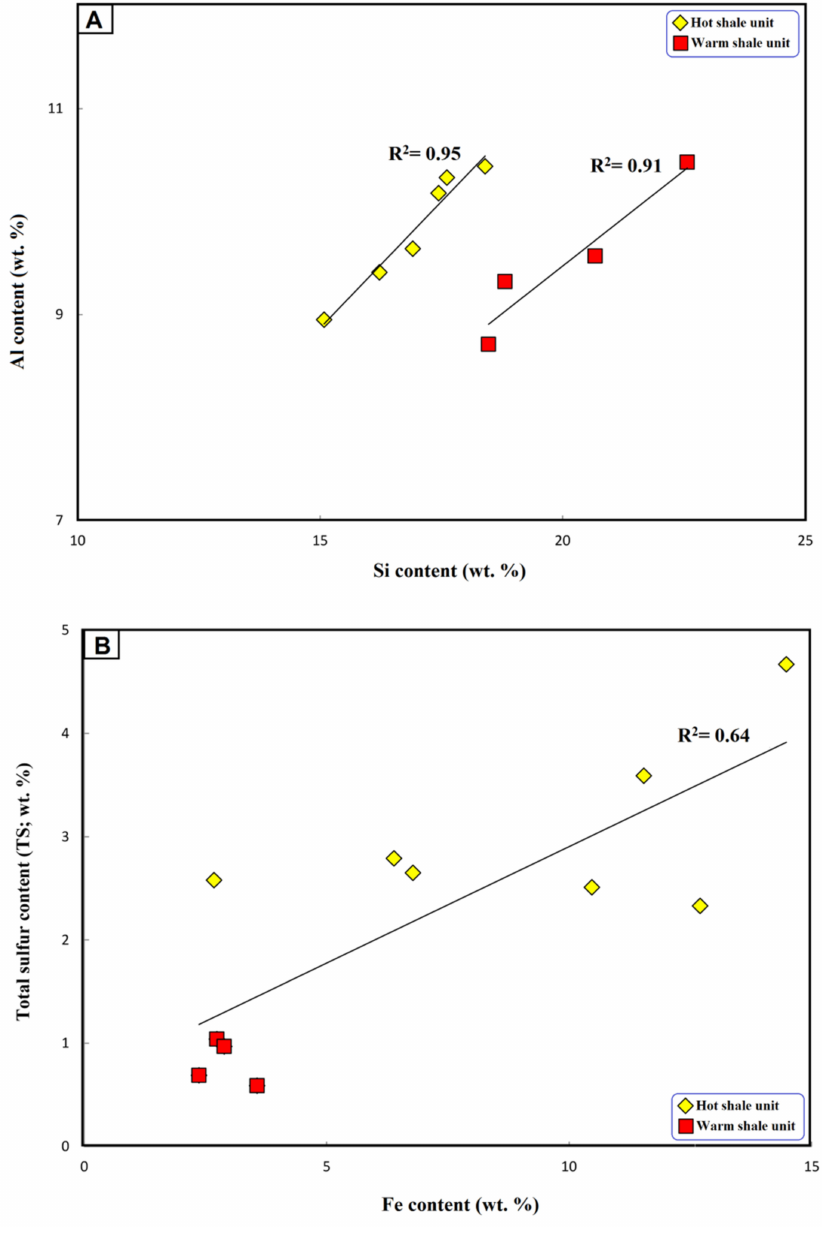
Figure 9. Geochemical correlations of inorganic geochemical elements the analyzed shales of the Qusaiba units, showing ( A ) Al versus Si and ( B ) Fe versus